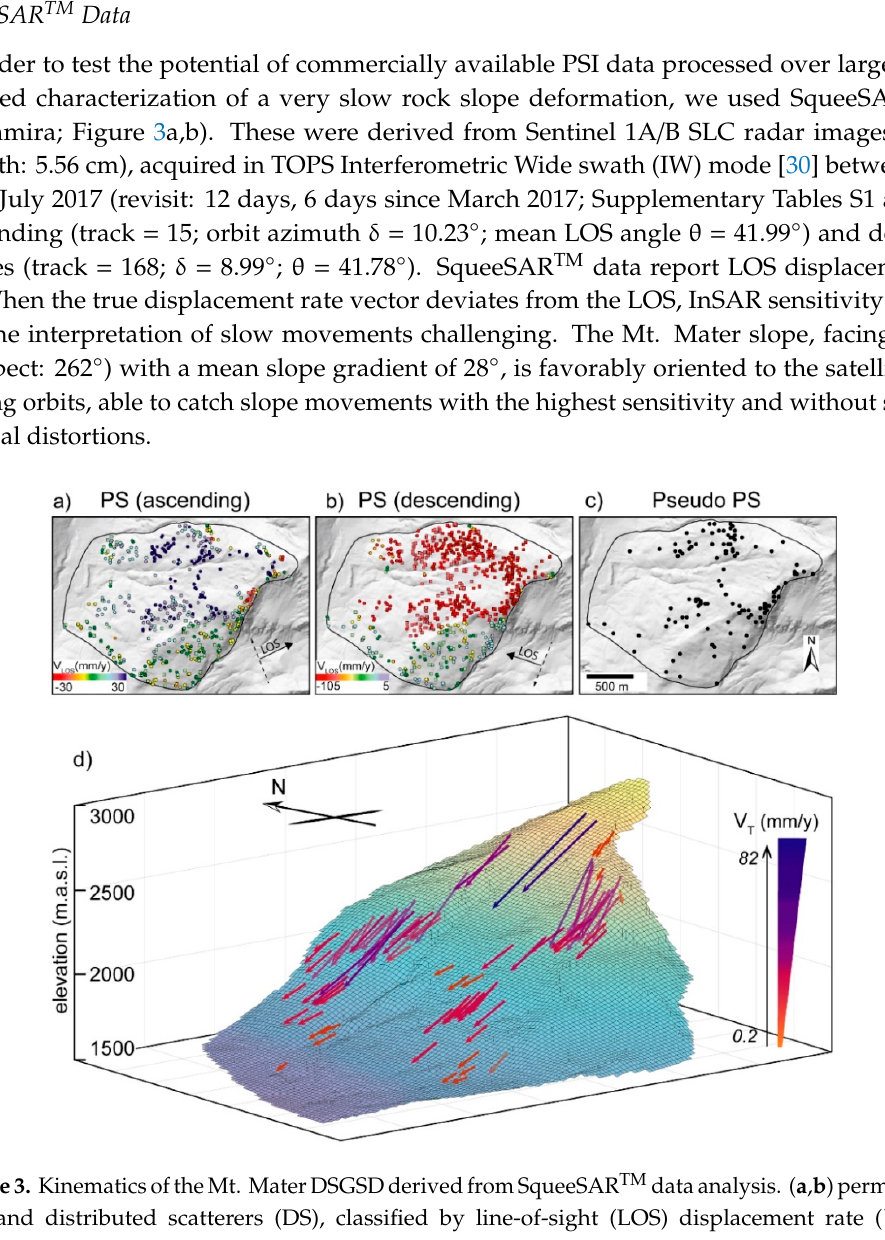
Figure 2. Time windows and temporal baselines covered by remote sensing and monitoring data.